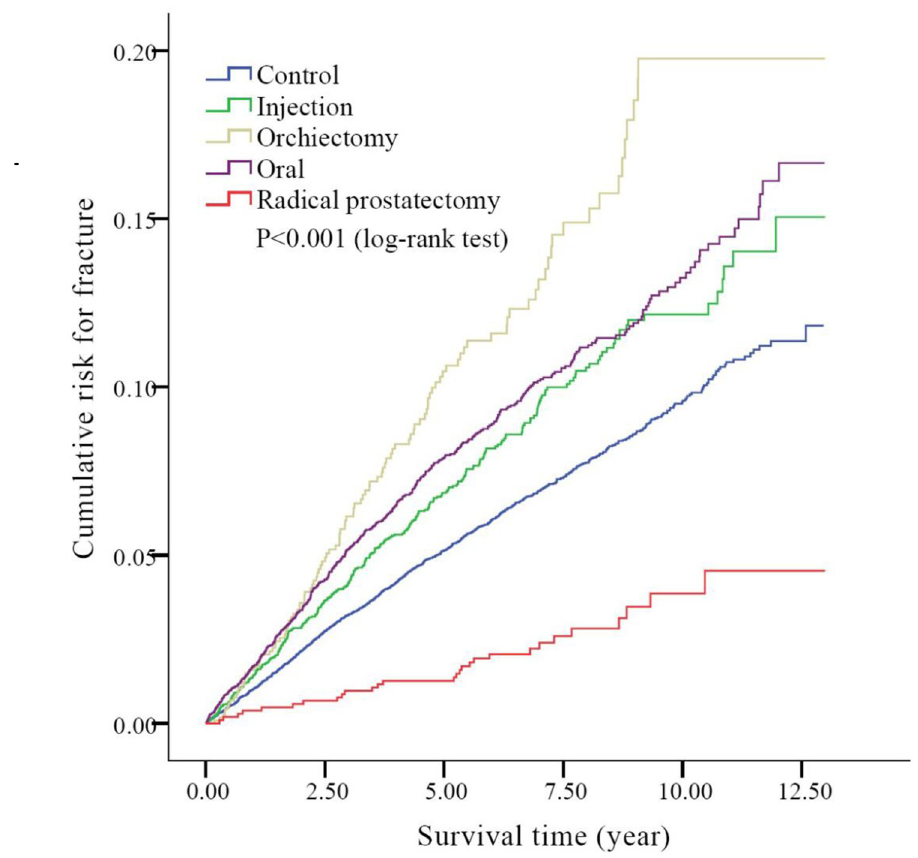
Fig 2. Kaplan-Meier cumulative incidence of developing fracture among five groups (P < 0.001, log-rank test) (n = 26,642).